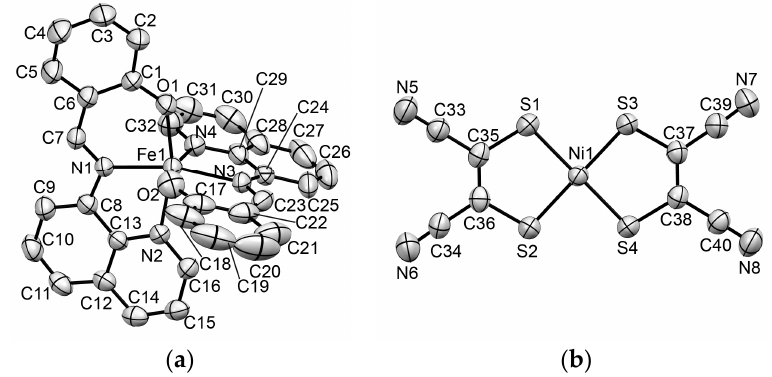
Figure 3. ORTEP drawings of 50% probability with atomic numberings for compound 1 at 293 K. ( a )